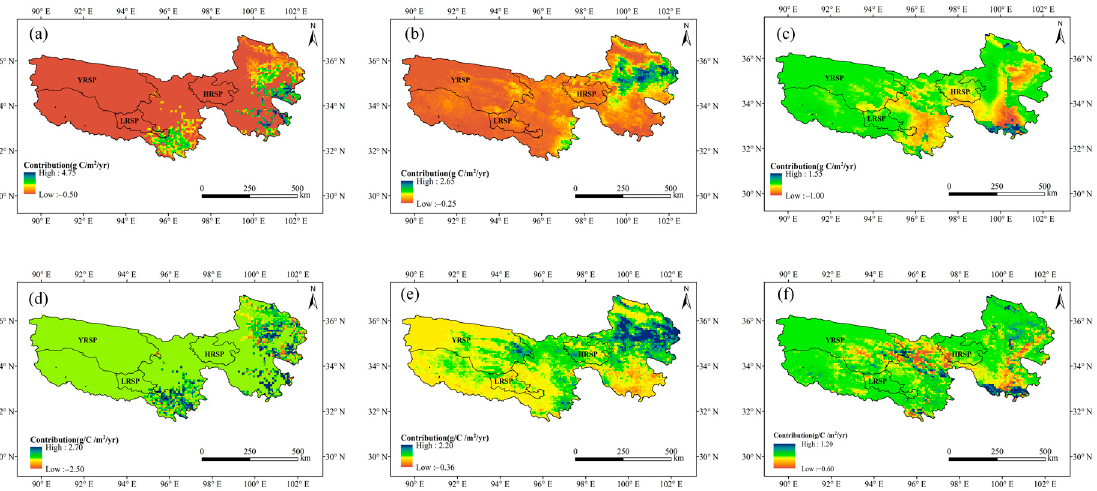
Figure 12. The contributions of temperature ( a , d ), precipitation ( b , e ) and solar radiation ( c , f ) to the GPP and NEP trends in the